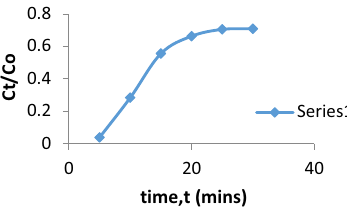
Fig. 9 Breakthrough curve at flow rate 3